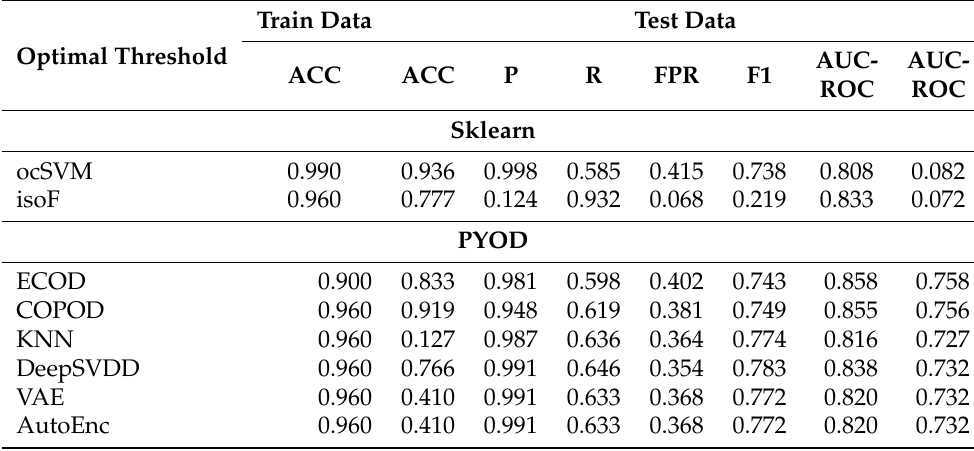
Table 8. The results of Experiment 3 for the SWaT